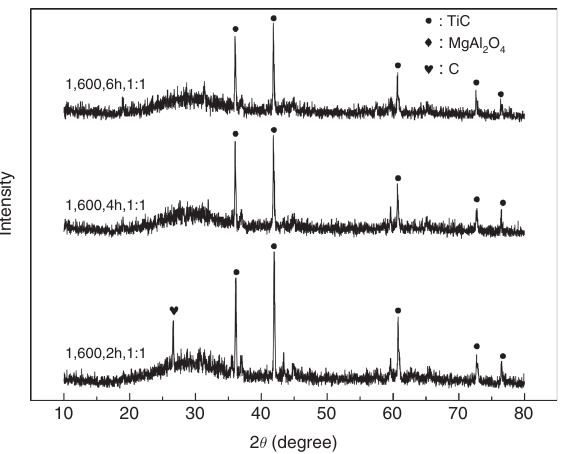
Figure 12: XRD results of reduced samples with carbon ratio of 1.0, at 1,773 K for different times: (a) 2 h, (b) 4 h and (c) 6 h.